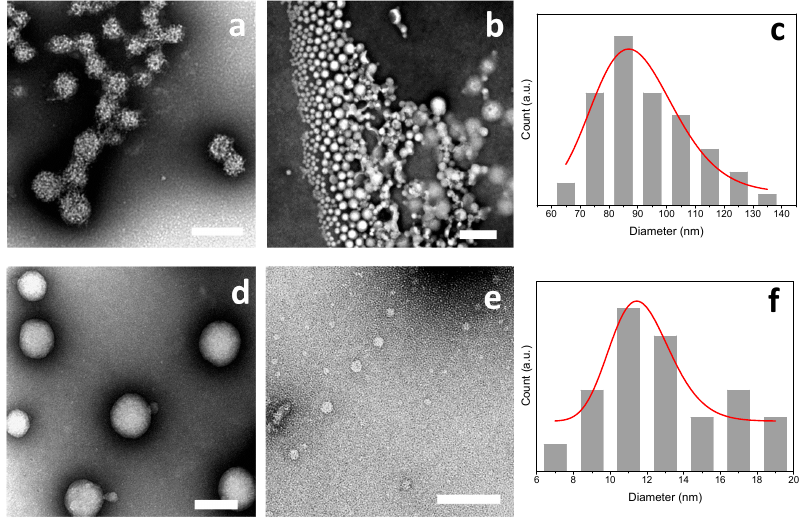
Figure 9. TEM micrographs of chitosan-caseinate PEC nanoparticles obtained in the experiments of Case II (caseinate in excess): (iv) by adding 0.1% (w/w) HMW CHI of low DA = 3% to 0.1% (w/w) sodium caseinate in CHI:NaCas volume ratios 1:10 ( a ) and 1:2 ( b ), with the corresponding dried nanoparticle size distribution ( c ) for CHI:NaCas volume ratio 1:2; (v) by adding 0.1% (w/w) deacetylated-LMW CHI of low DA = 3% to 0.1% (w/w) sodium caseinate in CHI:NaCas volume ratios 1:10 ( d ) and 1:2 ( e ), with the corresponding nanoparticle size distribution ( f ) for CHI:NaCas volume ratio 1:2. Scale bars: (a; b) 500 nm; (d) 200 nm; (e) 100 nm.